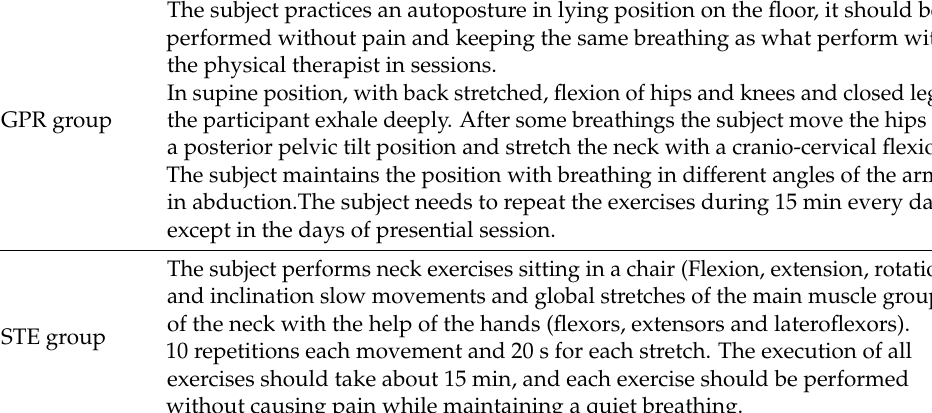
Table 2. Description of home exercises.